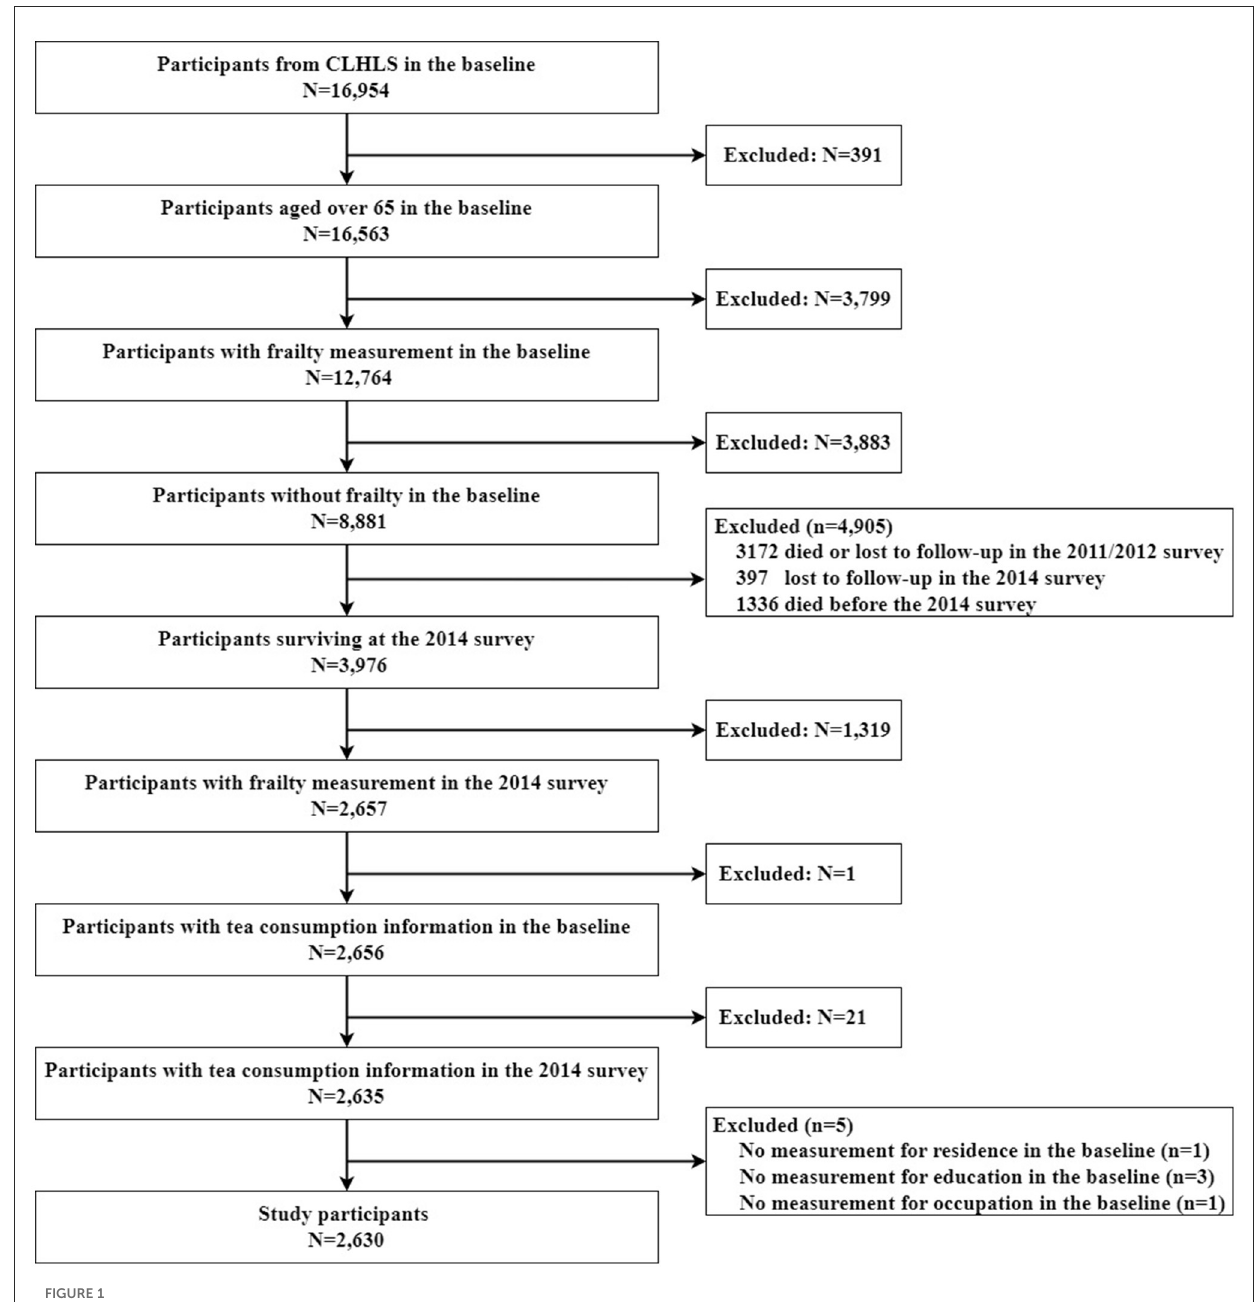
FIGURE1 Flow chart of sample